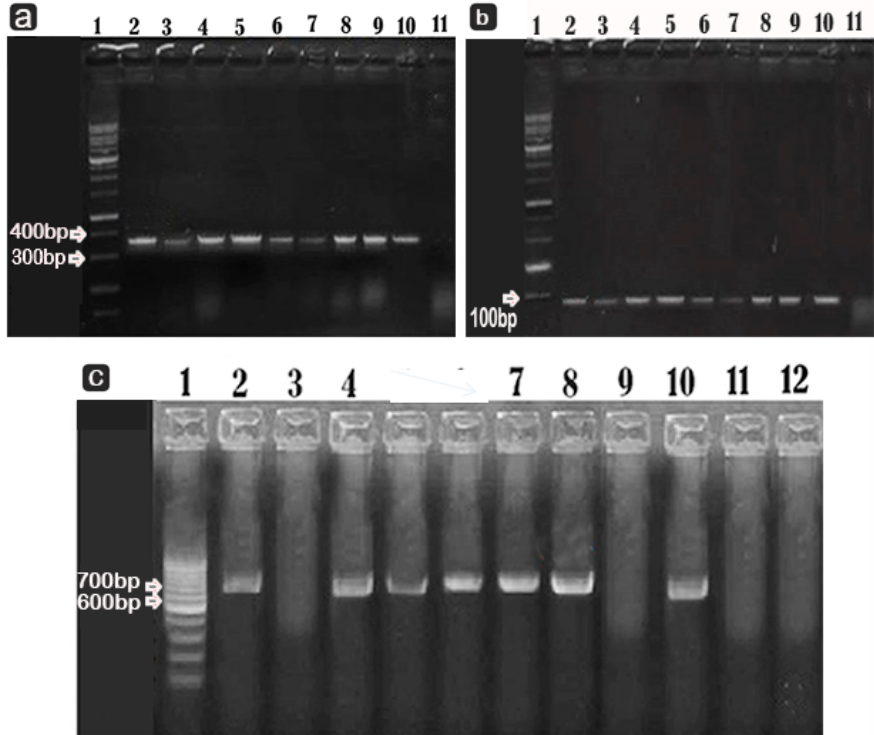
Figure 3. PCR results for biofilm formation genes ( a – c ) in Pseudomonas spp were detected on agarose gel electrophoresis. 369 bp for pslD ( a ), 89 bp for rhlA ( b ), and 786 bp for pelA are the expected molecular sizes of amplified DNA ( c ). lane 1 is DNA ladder, lanes 3–10 (3–6 P. aeruginosa and lanes